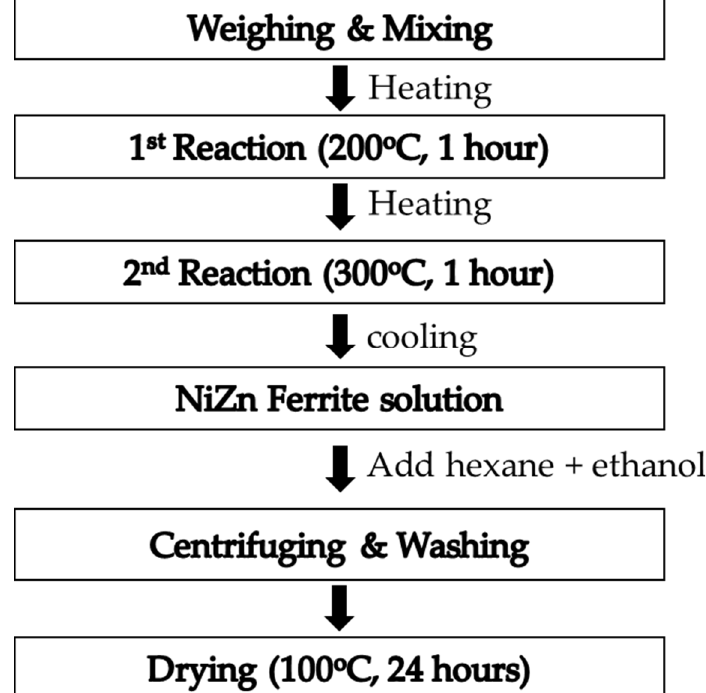
Figure2. ExperimentalprocedureforsynthesizingNi 1 − x Zn 1 − x Fe 2 O 4 (x = 0.3, 0.4, Figure 2. Experimental procedure for synthesizing Ni 1 − x Zn 1 − x Fe 2 O 4 (x = 0.3, 0.4, 0.5) ferrite nanoparticles.